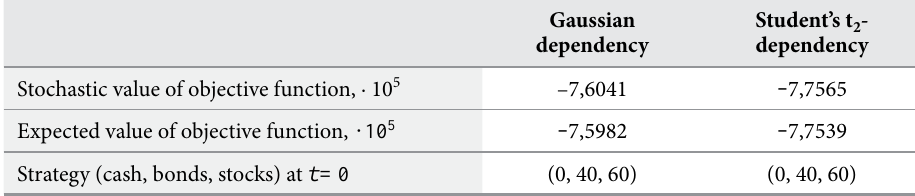
Table 5. The optimal values under different dependency structures without catastrophe event